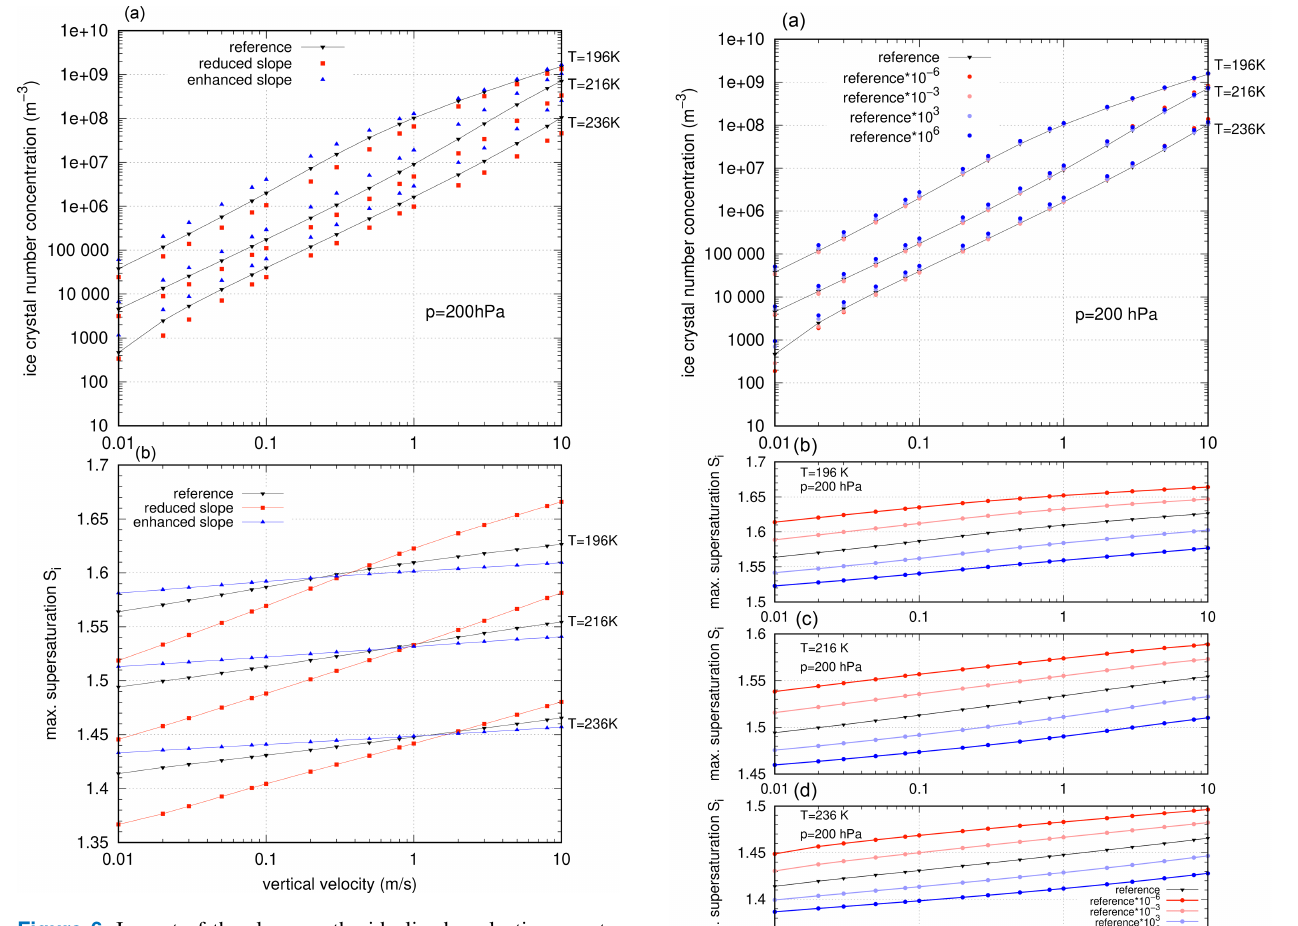
Figure 6. Impact of the slope on the idealized nucleation events. (a) Ice crystal number concentrations and (b) maximum supersatu- ration values. The colours are chosen as in Fig. 5; i.e. red squares indicate a reduced slope, and blue triangles indicate an enhanced slope, respectively. Figure 7. Comparison of ice crystal number concentrations (a)